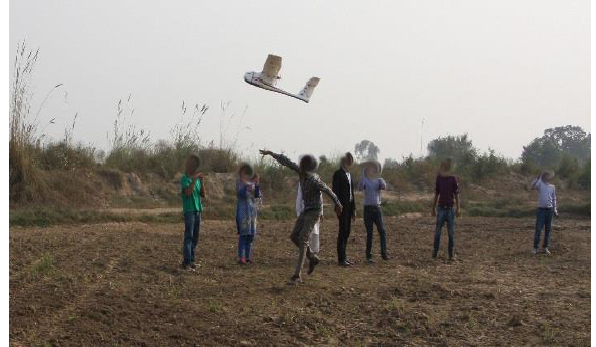
Figure 3. Automatic take-off of the GreenDrone UAV The UAV has flown along the planned waypoints taking images at locations scheduled by the mission planner software. Different flight paths were planned which took from 30 minutes to 60 minutes during each flight.